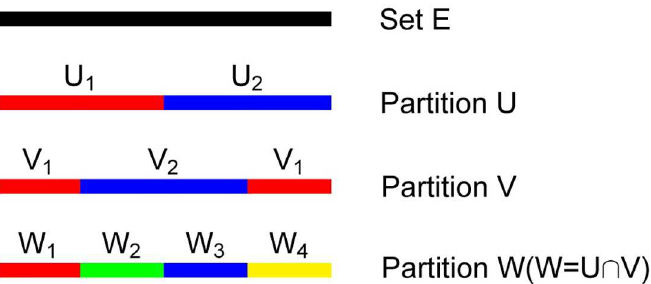
Fig 2. Example of obtaining a refined partition from coarse partitions. U , V and W represent different partitions for the set E . The bar with different colors represents a subset obtained by the corresponding partition, and the W partition is generatedby the intersection of U and V